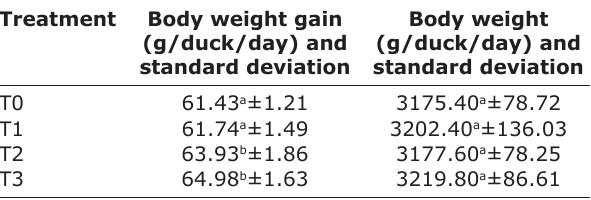
Table-1: Average body weight gain and body weight. Treatment